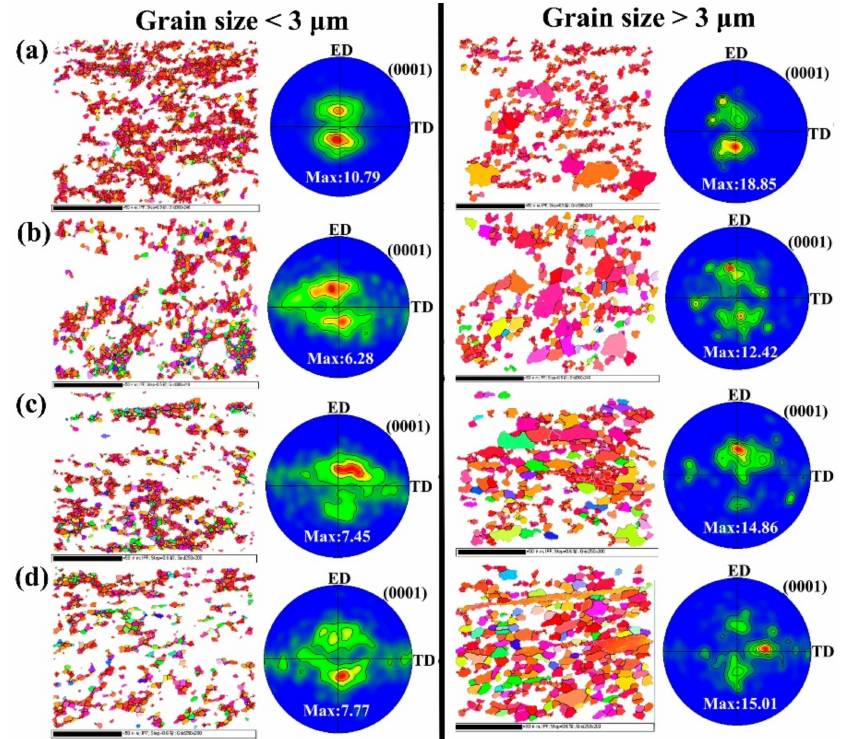
Figure 8. EBSD IPF maps in the ED-ND plane and {0001} pole figures of the four as-extruded Mg- 1.0Sn-0.5Ca-xZn alloys corresponding to grains with sizes <3 µ m and >3 µ m, respectively: ( a ) TX10 alloy; ( b ) TXZ100 alloy; ( c ) TXZ101 alloy; ( d ) TXZ102